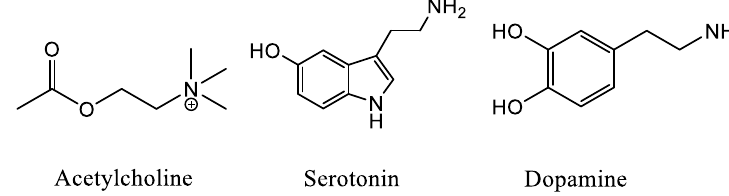
Figure 2. Chemical structure of the neurotransmitters ACh, 5-HT and DA.